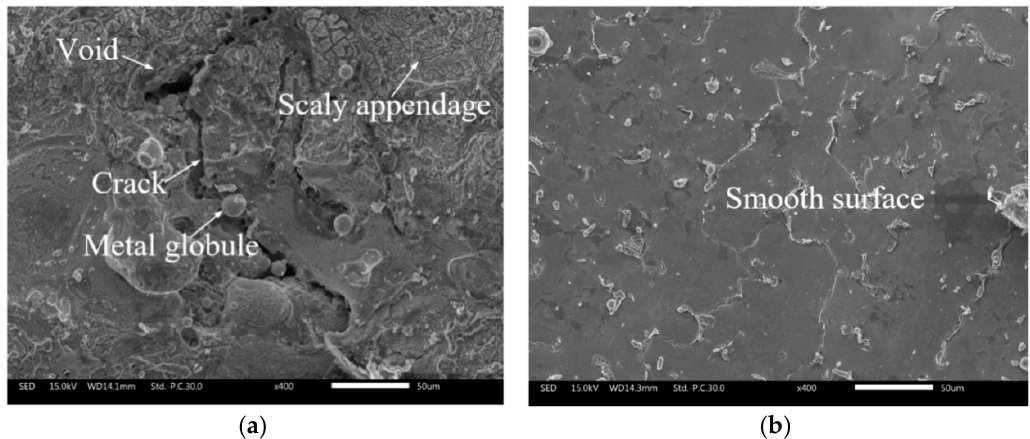
Figure 10. Comparison of cross-sectional surface morphology: ( a ) without ECM post-processing; ( b ) after ECM post-processing.